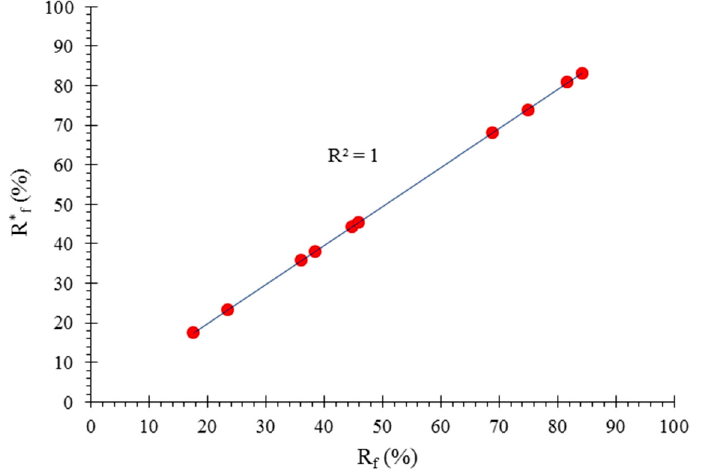
Figure 2. Comparison between the froth recovery data (R f and R* f ) obtained from Equations (6) and (7).